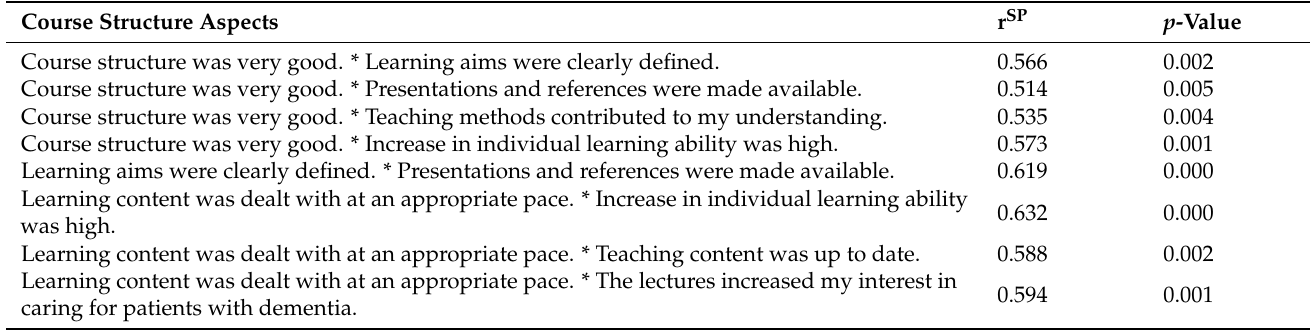
Table 2. Spearman correlation ‘course structure aspects’.